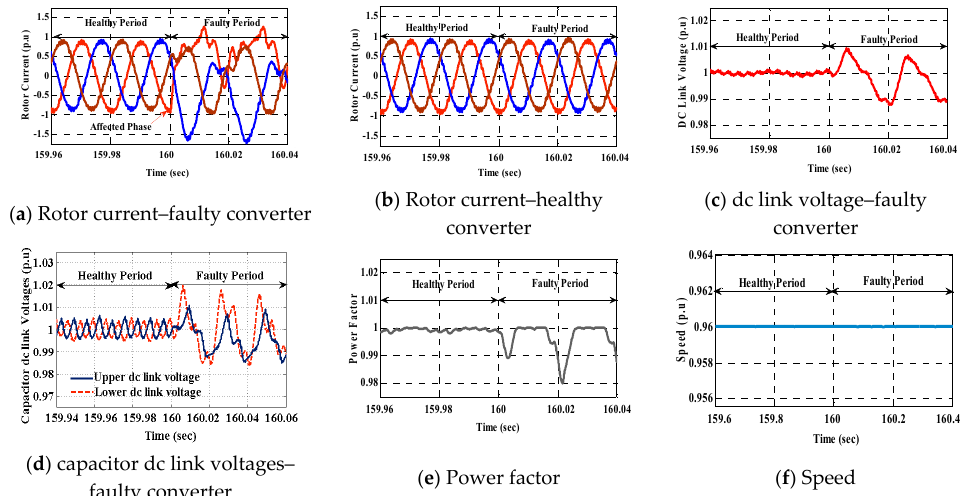
Figure 3. GSC upper single-switch open-circuit faults for a 250-MW DFIM unit.